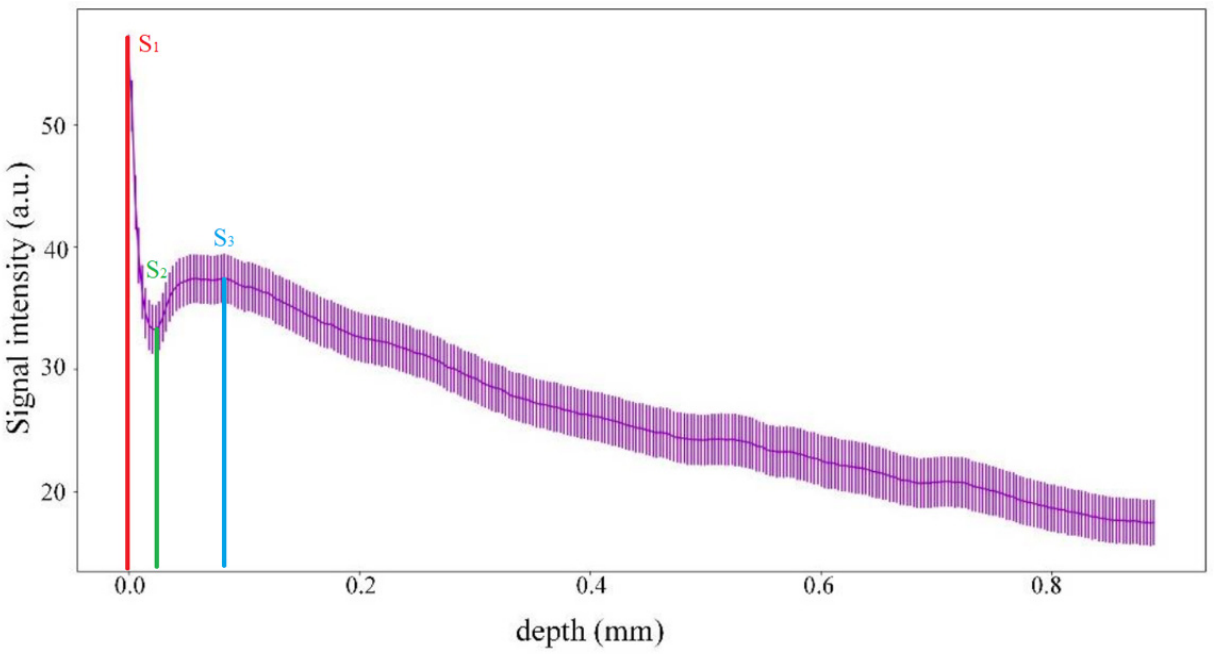
Figure 4. Dependence of signal intensity on depth for healthy skin: S 1 start point of the stratum corneum; S 2 —the endpoint of epidermis; S 3 —start point of the dermis.